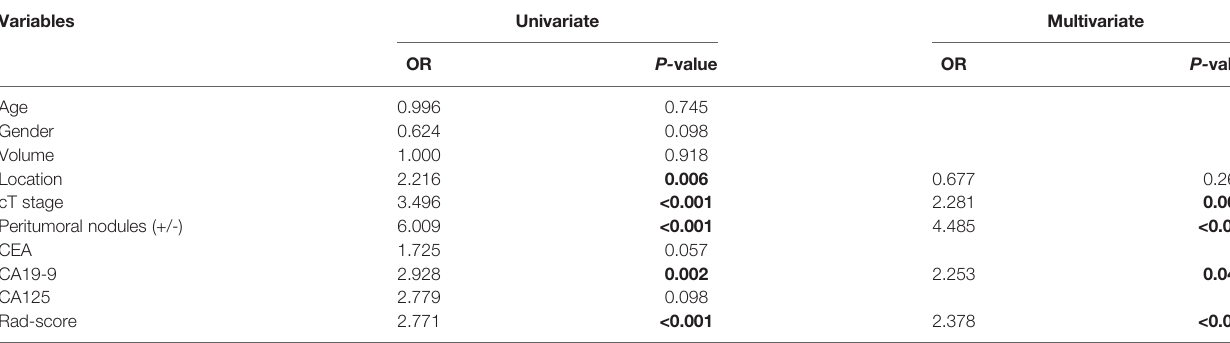
TABLE 2 | Risk factors selected by the logistic regression analysis.